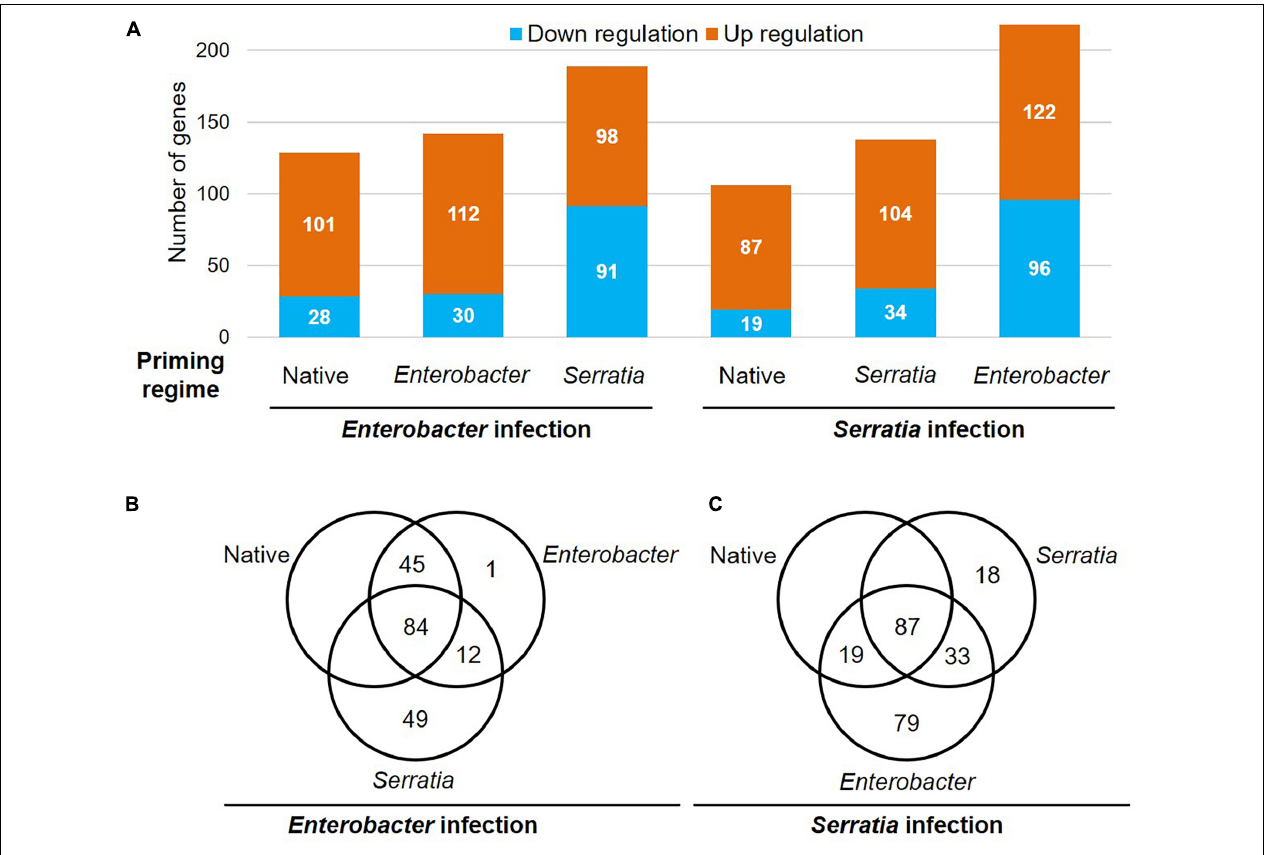
FIGURE 9 | Priming effects on the transcription of the immune genes upon Enterobacter and Serratia challenge. (A) The number of upregulated or downregulated genes is presented in each priming regime upon respective bacterial challenge. (B,C) The Venn diagram exhibits genes that were responsive to the respective infection in the cohort with respective priming